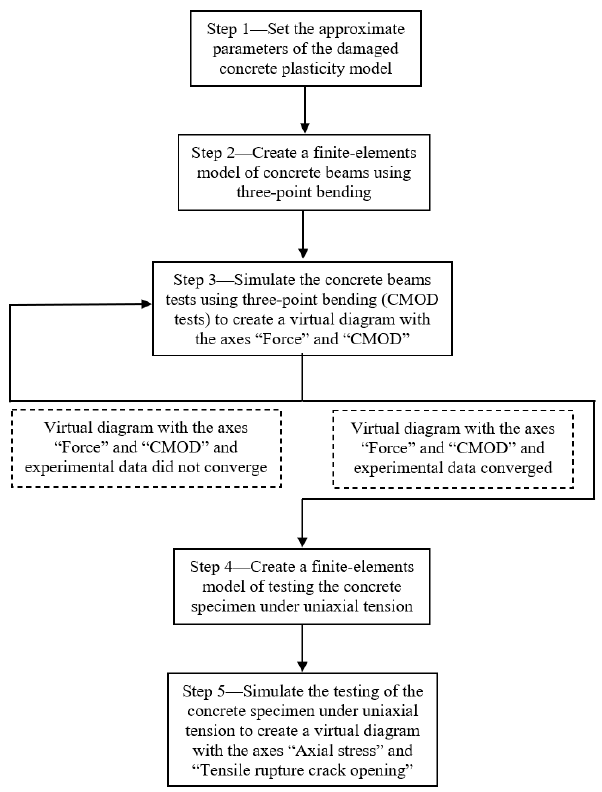
6 of 16 Figure 4. Tensile damage factor versus CMOD according to CMOD test data.